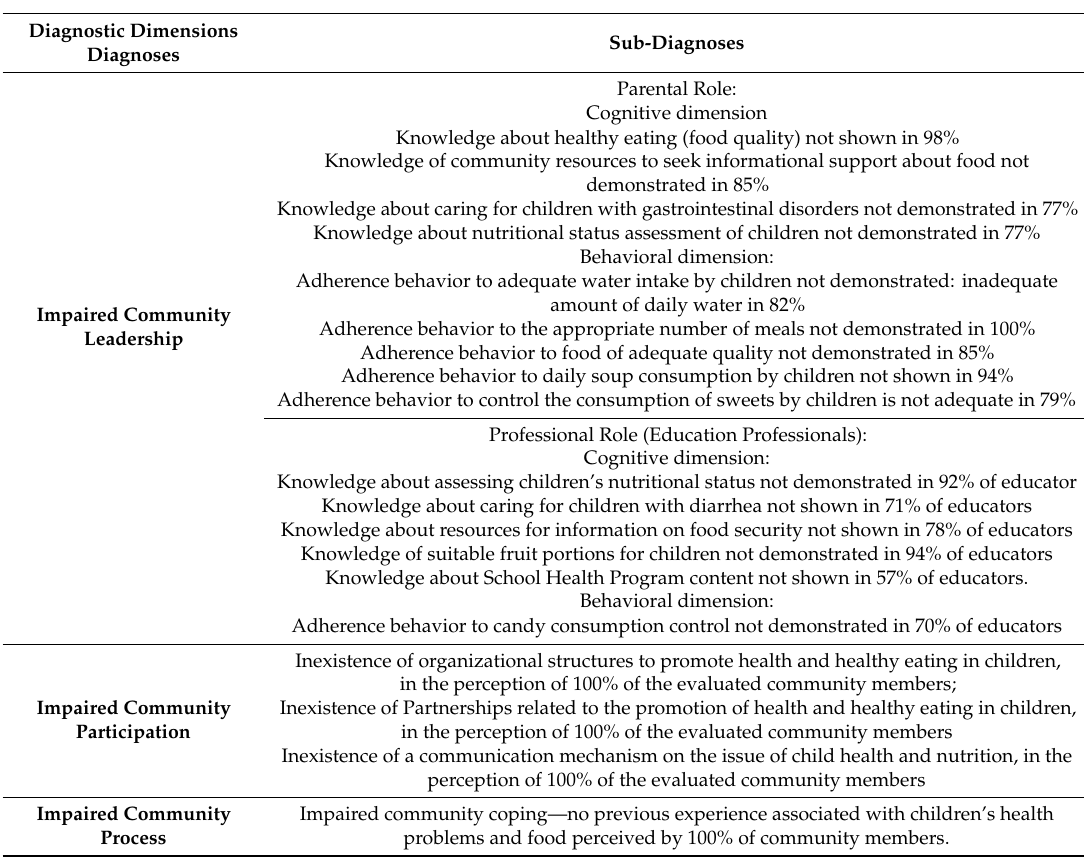
Table 5. Diagnostic Dimensions Diagnoses and Sub-Diagnoses Identified in the Context of the Administrative Management